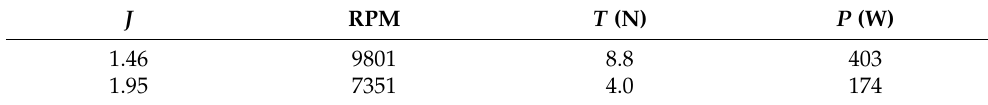
Table 2. Scaled propeller performance requirements ( D = 146mm, V ∞ = 35m/s).